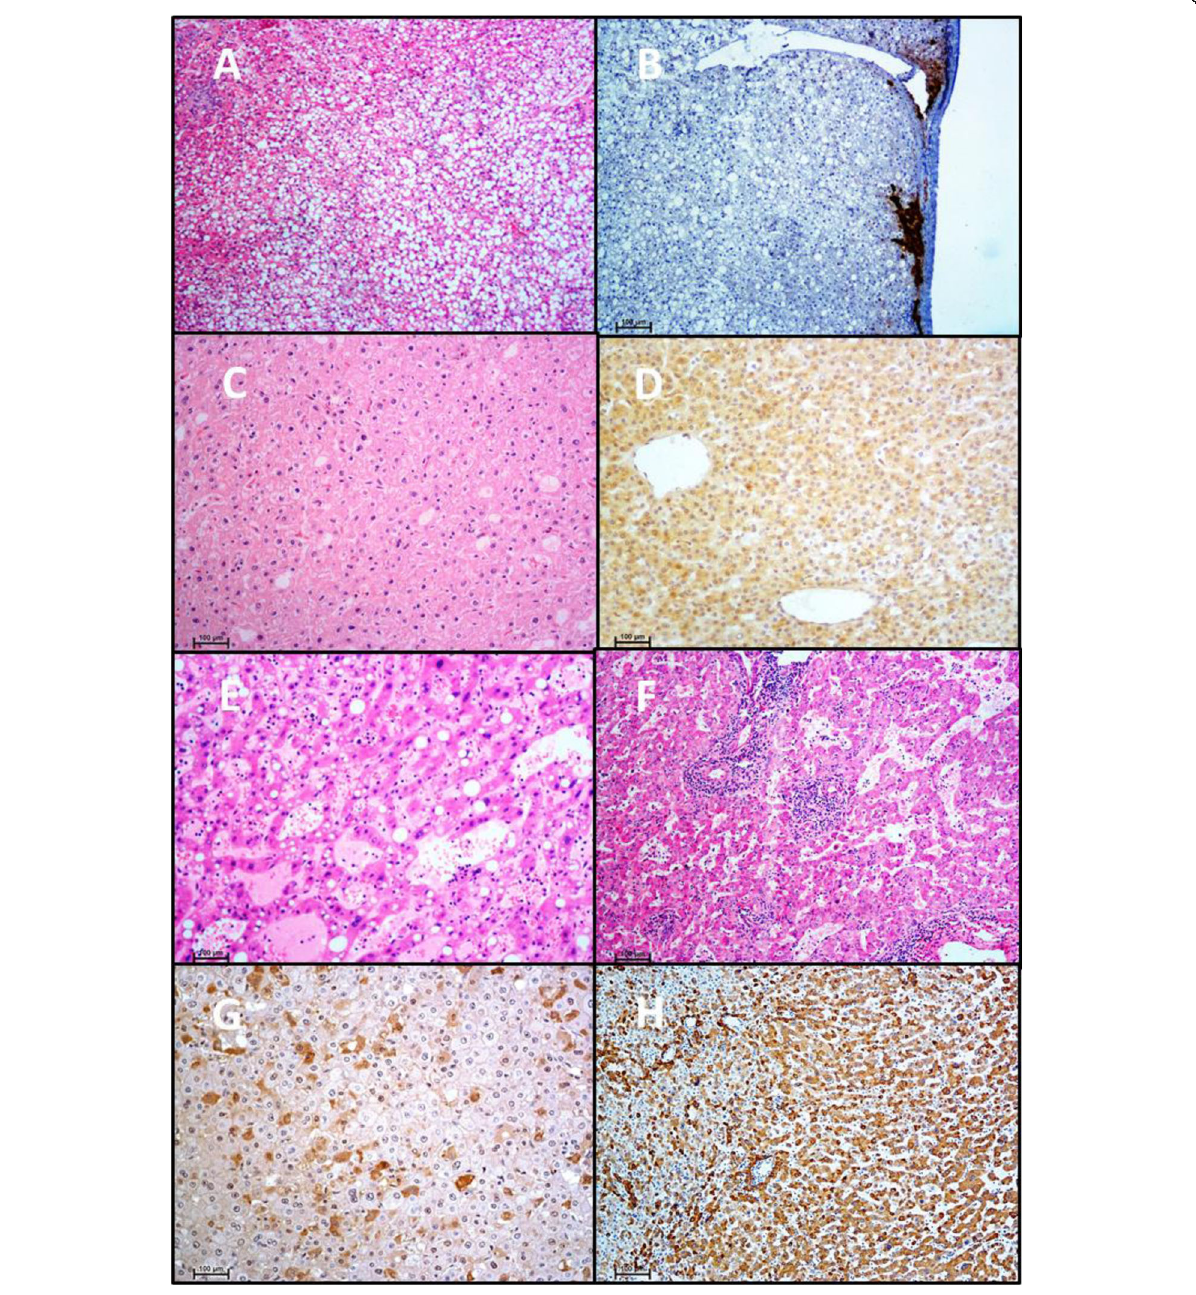
Fig. 1 a HHCA - HE: diffuse steatosis; b HHCA - LFABP immunostaining negative; c bHCA - HE: pseudoglands ( d ) bHCA - diffuse immunoexpression of GS; e IHCA - HE: sinusoidal dilatation, mild steatosis; f IHCA - HE: patchy inflammation, sinusoidal dilatation and pseudoportal tract formation; g IHCA - SAA immunoexpression; h IHCA - CRP